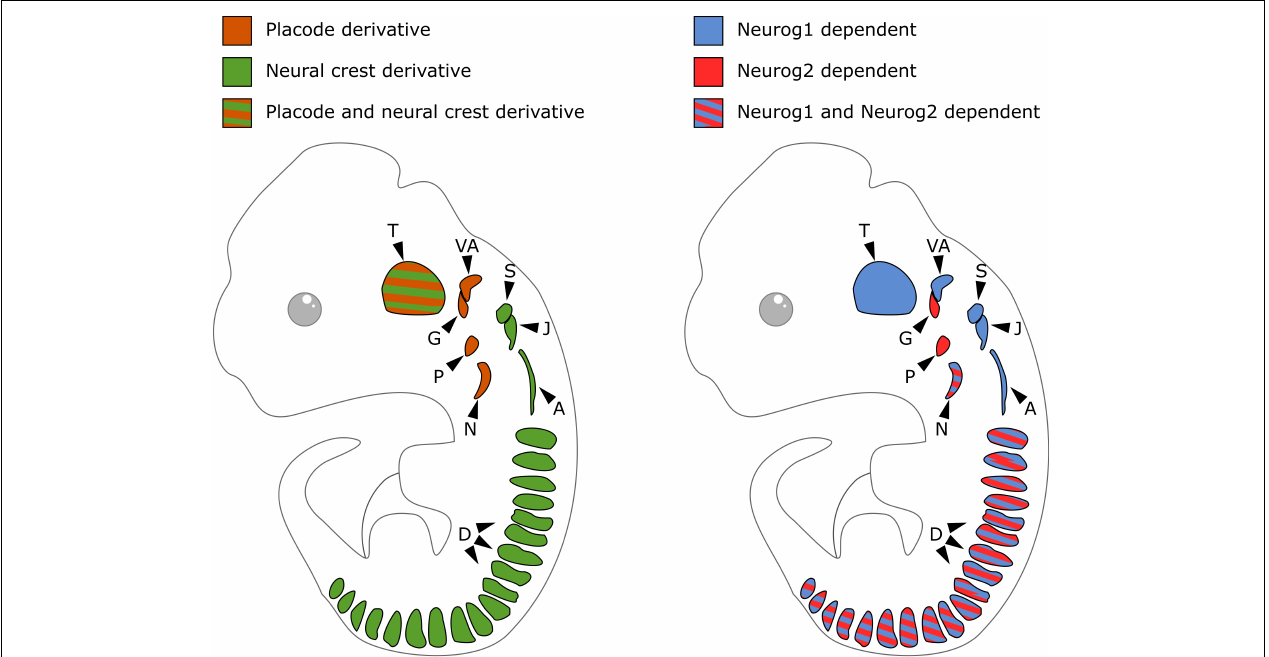
FIGURE 2 | Embryonic origin and differential contribution of Neurog1 and Neurog2 to neurogenesis in the sensory ganglia. On the left, schematic of cranial sensory ganglia with indication of the contribution of neural crest (green) or placode (orange) to their formation. On the right, schematic of sensory ganglia and their developmental dependence to Neurog1 (blue) or Neurog2 (red). A, accessory ganglia; D, dorsal root ganglia; G, geniculate ganglion; J, jugular ganglion; N, nodose ganglion; P, petrose ganglion; S, superior ganglion; T, trigeminal ganglion; VA, vestibuloacoustic ganglion.